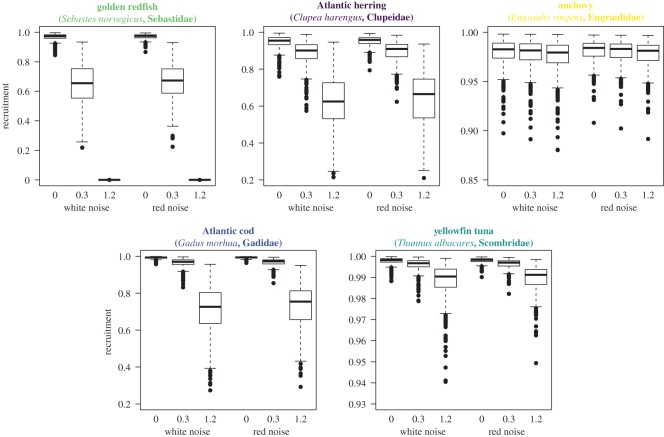
Response of recruitment to environmental disturbance and/or fishing of five selected species with varying life histories within the parameter space of growth and asymptotic size (anchovy, Atlantic cod, Atlantic herring, golden redfish and yellowfin tuna, table 3 for details). Their respective spread in recruitment (can be seen as variability) is plotted for each of the scenarios. The three boxplots on the left of each respective species indicate scenarios with white noise with no fishing, with 0.3 year−1 fishing mortality and 1.2 year−1 fishing mortality; followed by the three scenarios with red noise. Note the varying y-axis scales.